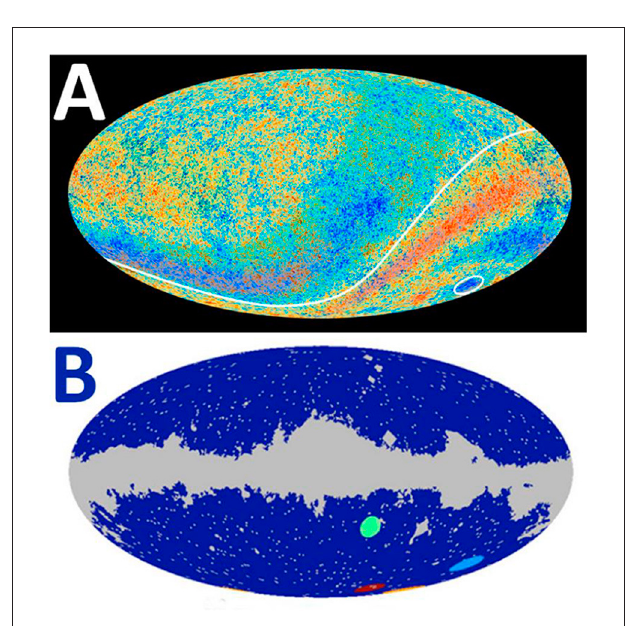
FIGURE 2 | Map of the cosmic microwave background (CMB) radiation. (A) The Axis of Evil and a mystery cold spot stand out in this enhanced version of the best map yet of the CMB radiation obtained by the ESA Planck spacecraft. Data released in 21 March 2013. Credits: ESA-Planck collaboration (B) Four candidate “bruises” are in the lower-right quadrant of this all-sky map of the CMB, in green, light blue, red and orange (bottom edge of image). Data from NASA’s Wilkinson Microwave Anisotropy Probe (WMAP) and from Feeney et al. (2011). Credits: The American Physical Society, http://dx.doi.org/10.1103/